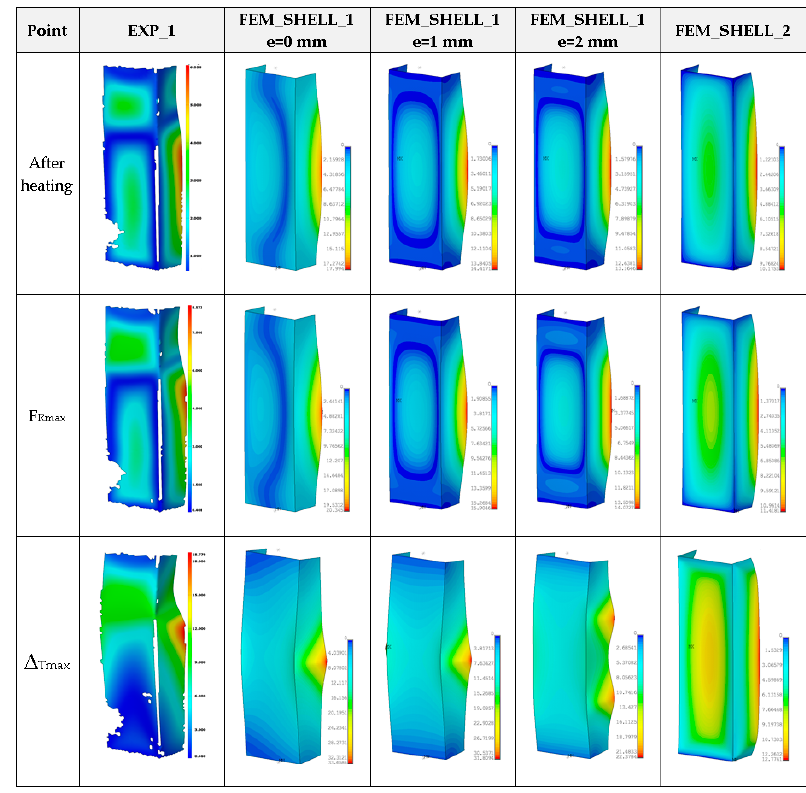
Figure 25. The compression curves of column at 200 °C.